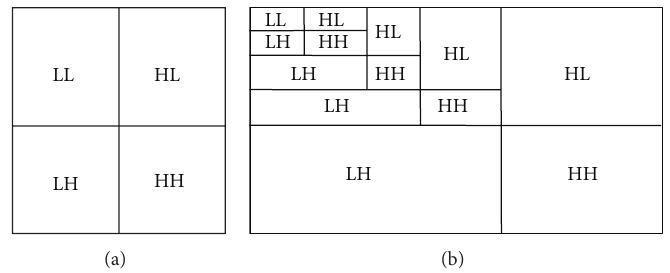
Figure 2: (a) Wavelet decomposition and (b) 4-level wavelet decomposition.